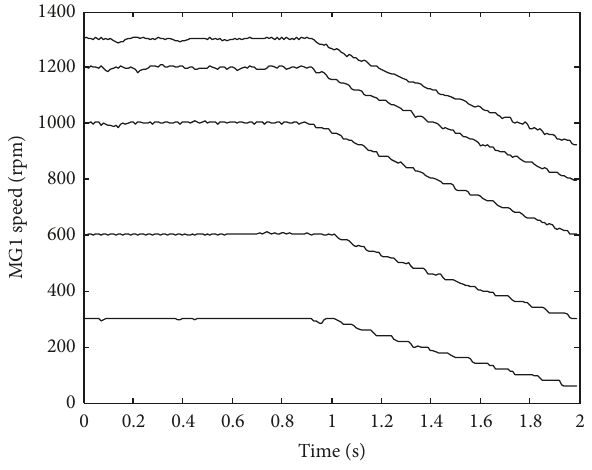
Figure 10: MG1 free-fall speed